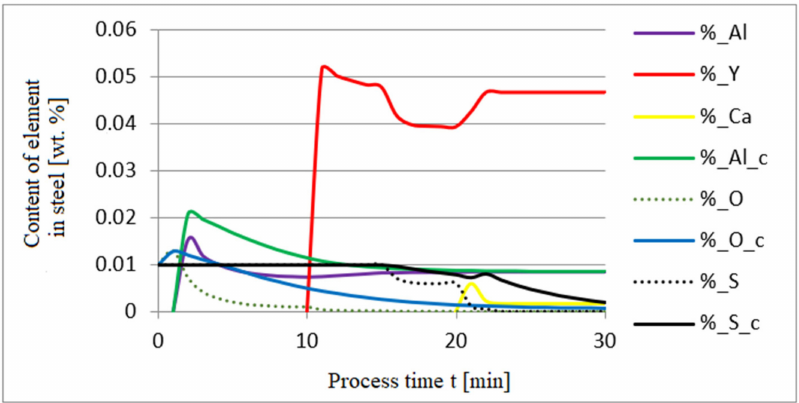
Figure 2. Change in the content of an element in liquid steel (wt.%) depending on the process time t (min).